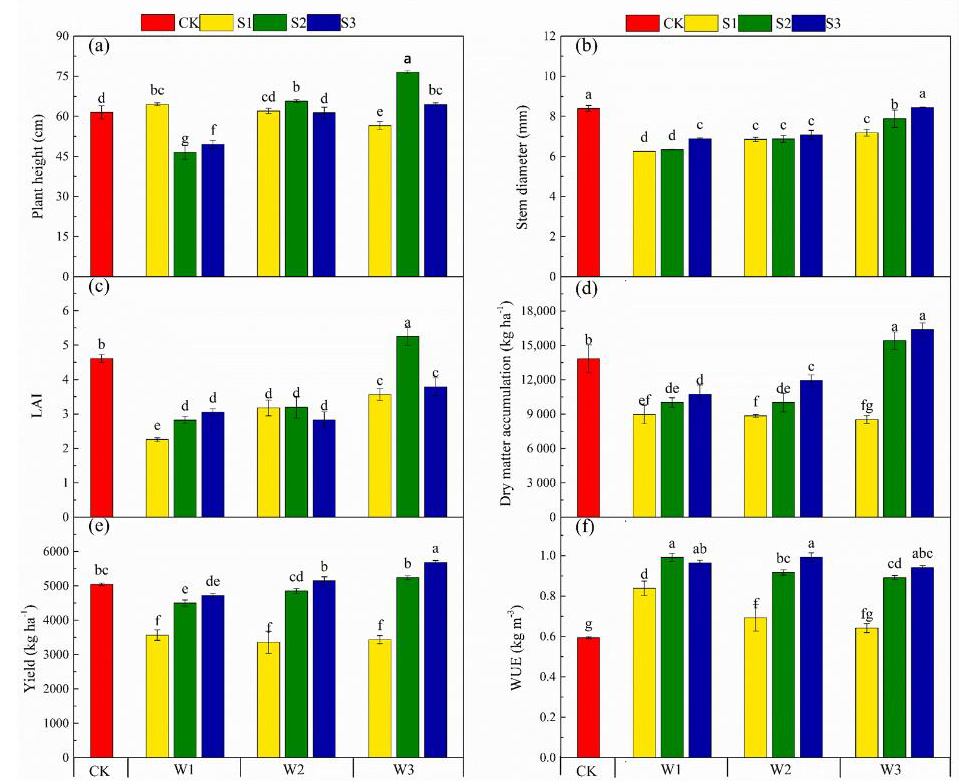
Figure 6. Cotton growth, yield and WUE under different treatments. ( a ) plant height; ( b ) stem diameter; ( c ) LAI; ( d ) dry matter accumulation; ( e ) yield; ( f )